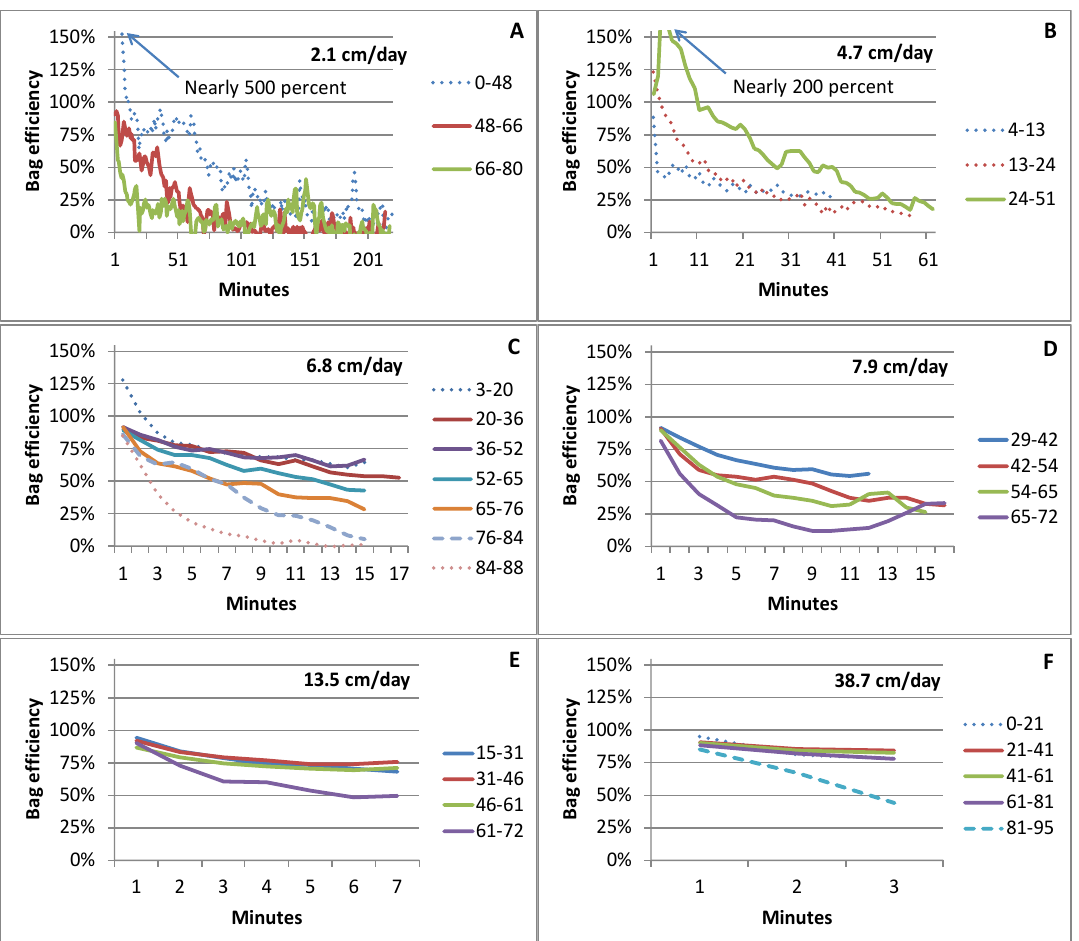
Figure 4. Effect of bag fullness on bag efficiency during upward seepage. Bag efficiency is plotted for each minute the bag was attached to the ESM. Bag-attachment plots are labeled based on the percent fullness of the bag at the beginning and ending of each attachment (i.e., 0–48 indicates the bag was 0 percent full at the beginning of the attachment and 48 percent full at the end of the attachment). Panels ( A – F ) represent: tests conducted with seepage rates ranging from 2.1 to 38.7 cm/d, respectively. Values in bold in each chart are average seepage rates through the ESM (cm/d) when no bag was attached. Dotted or dashed lines indicate tests when bag fullness was largely outside of the recommended 25 to 75 percent.